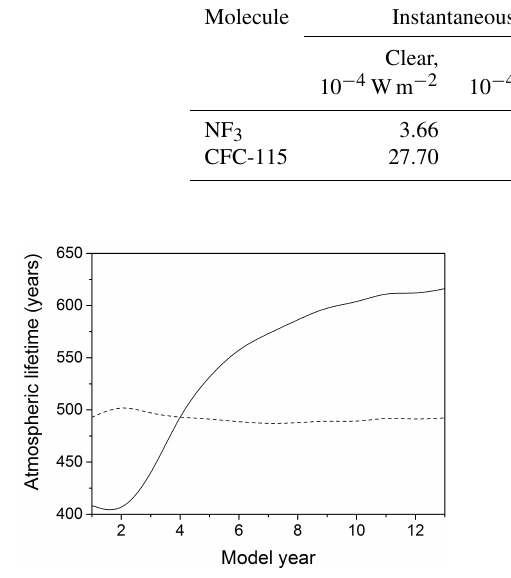
Table 4. Instantaneous and stratosphere-adjusted radiative forcings of NF 3 and CFC-115 in clear- and cloudy-sky conditions. Molecule Instantaneous Adjusted Clear, All-sky, Clear,